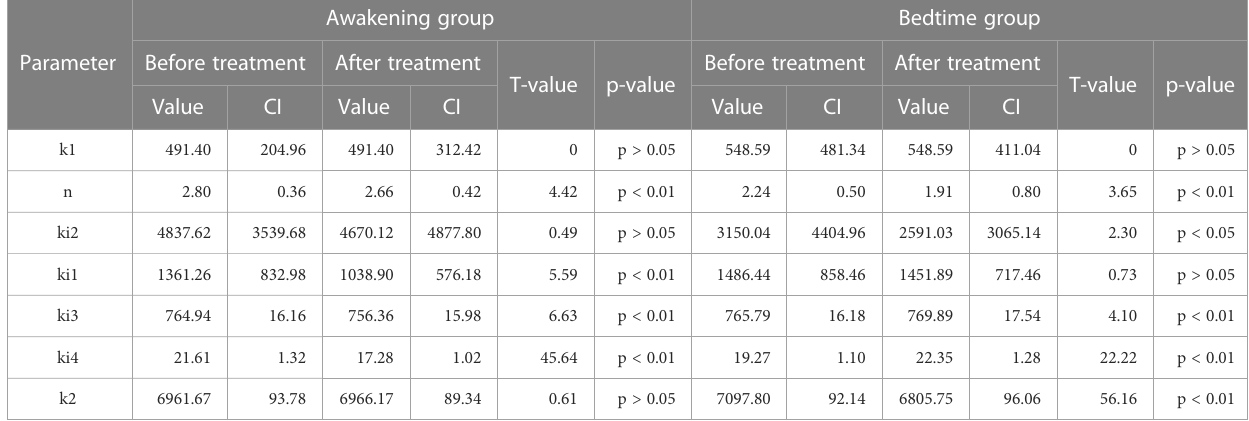
TABLE 2 Estimated parameters for awakening and bedtime administration of aspirin.